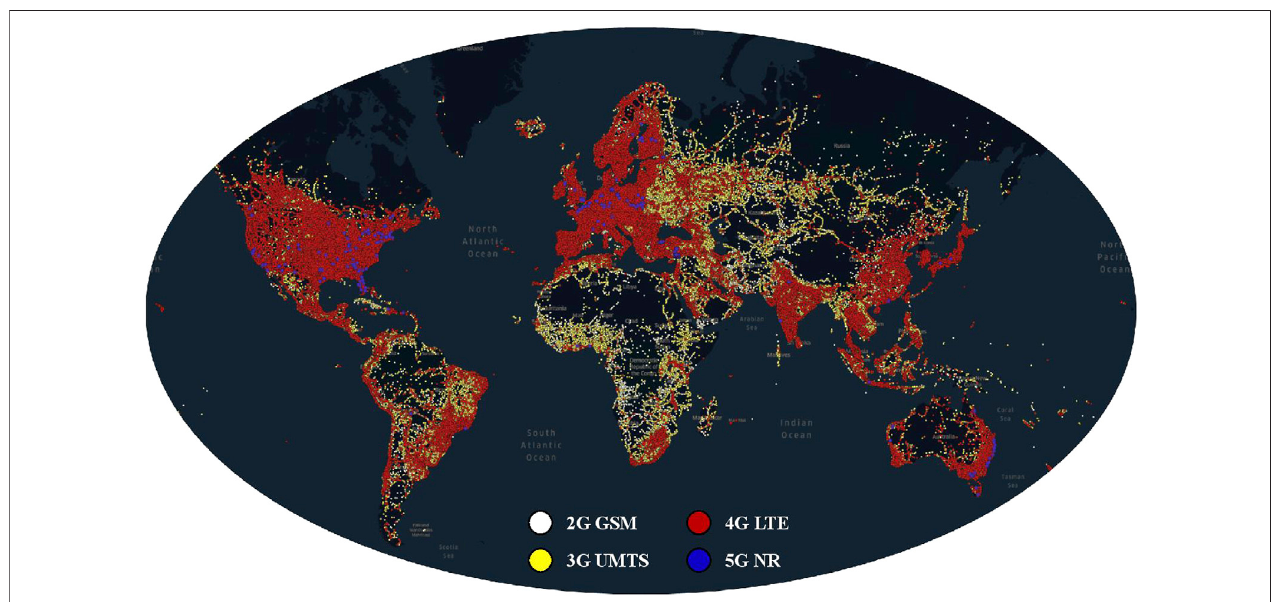
FIGURE 1 | Worldwide BS distribution between Jan. 2000 and Dec. 2020 all over the world: A visualization of the global digital divide.